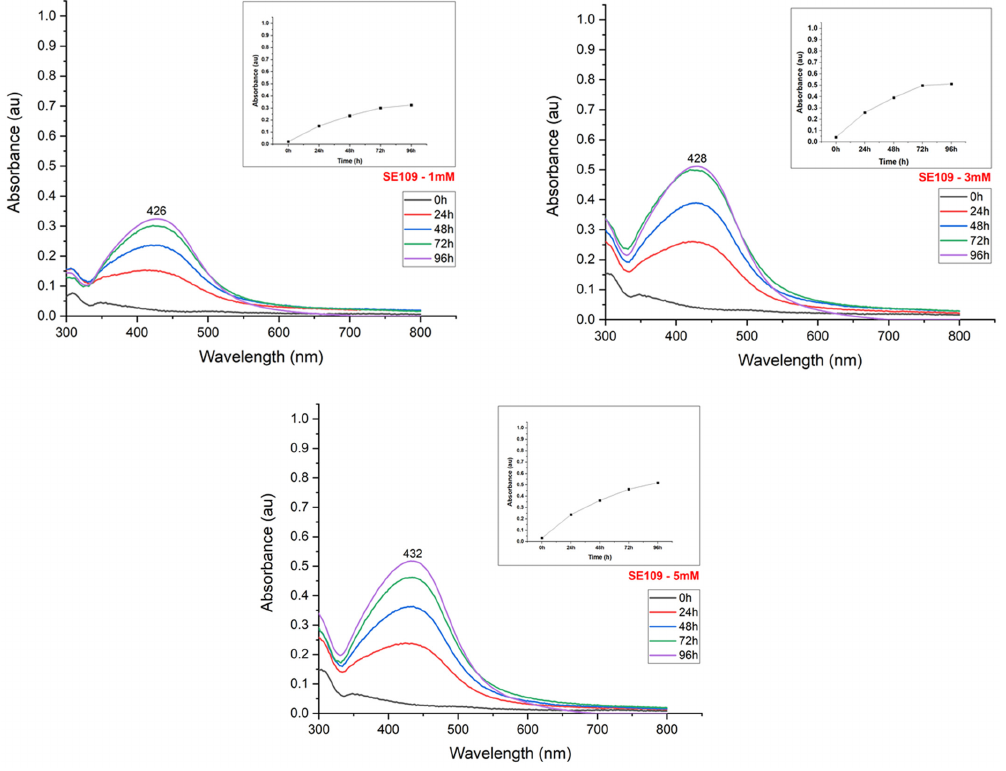
Figure 4. UV-Visible absorption spectrum of the evaluation of the effect of silver nitrate concentration on the synthesis of silver nanoparticles using an extract of the fungus B. bassiana (isolate SE109).